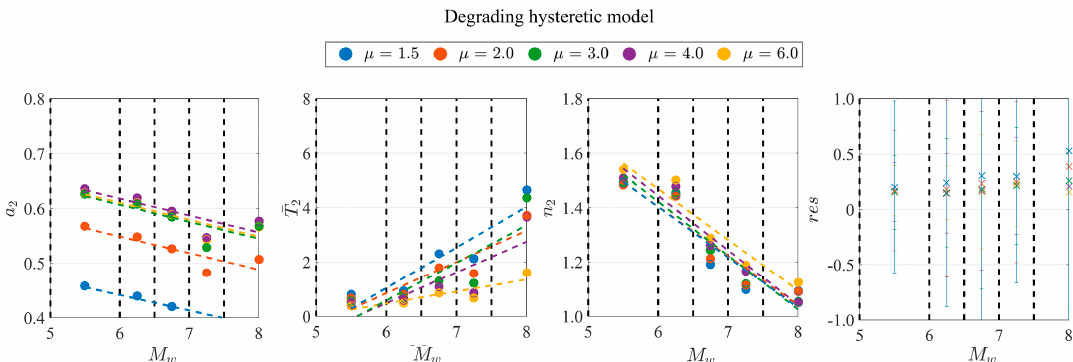
Figure 15. Constants involved in the regression analysis of the mean spectra of the hysteretic energy reduction factor R Ha for hysteretic degrading behaviors (dots: regression results; line: proposed closed-form relationship), together with the regression error chart.